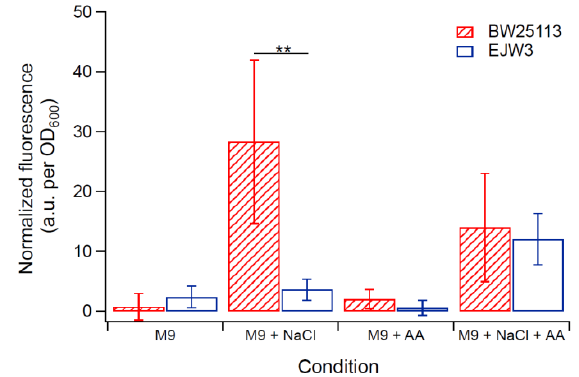
Figure 7. Membrane integrity assay using PI staining of exponential growing cells. NaCl: 0.7 M NaCl. AA: 10 mM acetic acid. ** Statistically significantly different using two-tailed student’s t -test ( p -value < 0.005). Error bars are standard deviations.